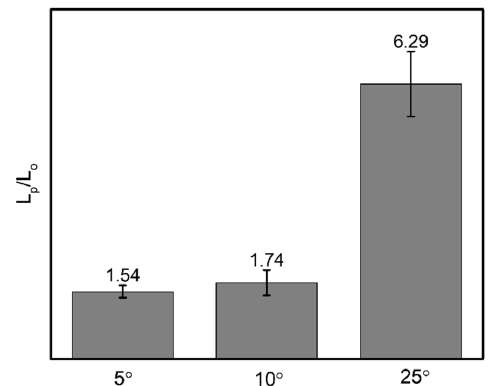
Figure 10. The ratio presents the predominant wetting distance (L p ) to the opposite one (L o ) corre- sponding to various α angles.